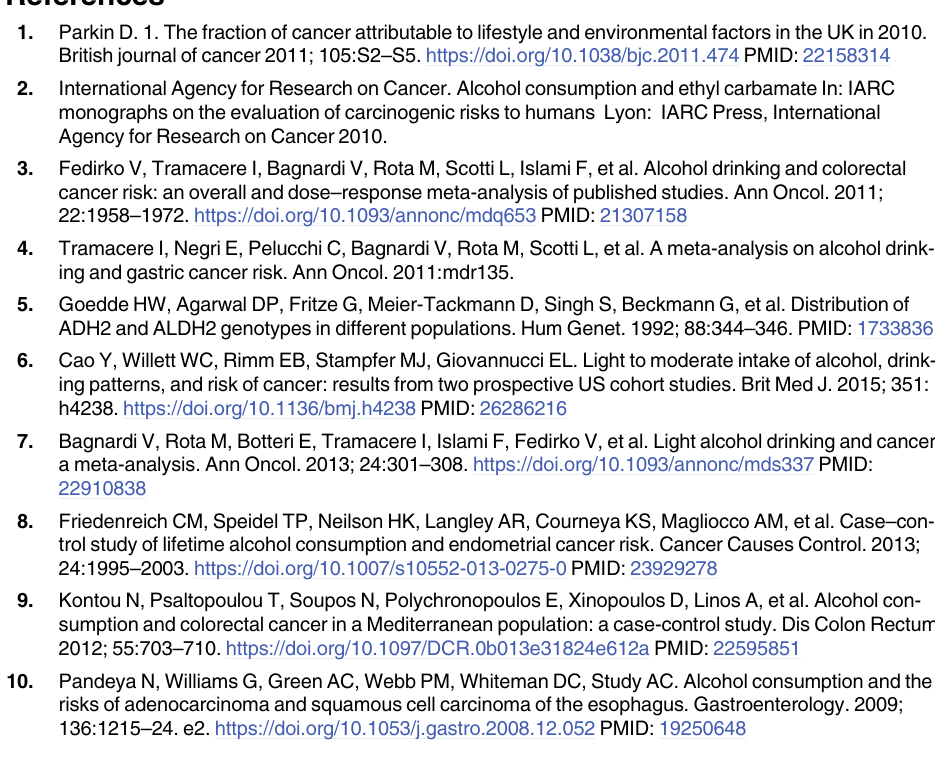
S1 Table. Number of cancers and adjusted hazard ratios of the three gastrointestinal can- cers according to the amount of alcohol consumed